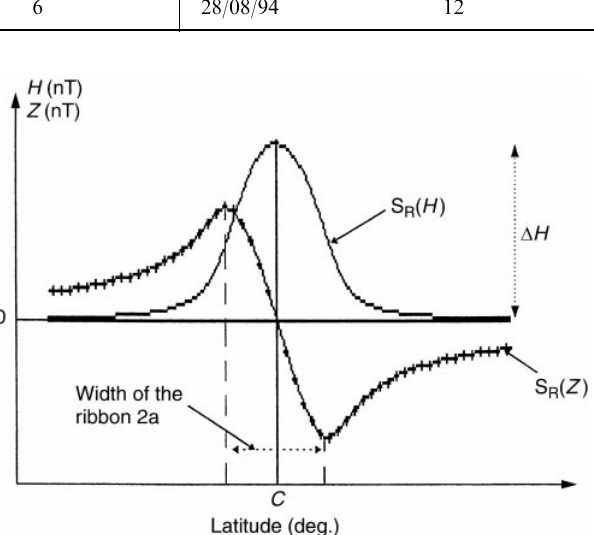
Fig. 12. Magnetic e(cid:128)ect of a parabolic electric current (center C , width 2 a and amplitude (cid:68) 10 The seasonal variability The seasonal variability of the parameters characterizing the EEJ at 12 h is obtained by computing the monthly means of (cid:68) H at noon, of the electrojet center, and of the electrojet half-width. Figure 15 displays these monthly means with corresponding rms error-bars.